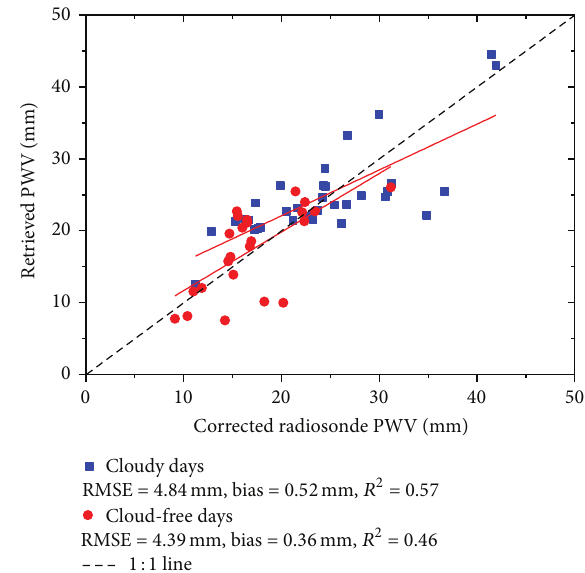
Figure 6: Comparison of the corrected radiosonde PWV and retrieved PWV for cloud-free days (red circles) and cloudy days (blue squares) at Zhangye National Climate